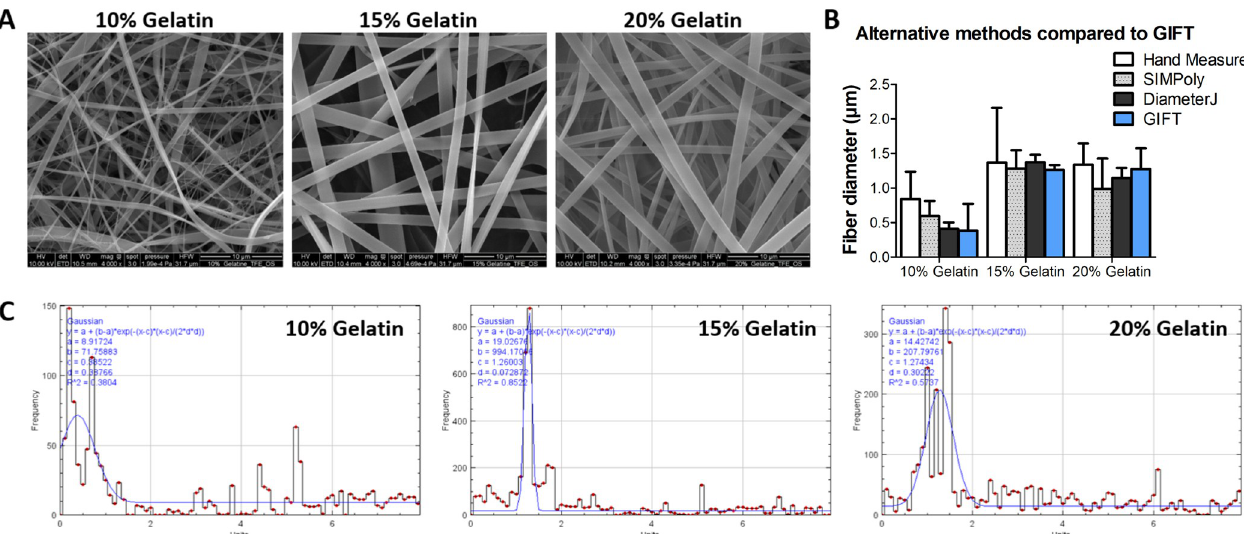
Fig 2. Real world image analysis. A) SEM images of electrospun fibers made from 10, 15 or 20% gelatin solutions. Manual fiber diameter measurements were made on 10 random fibers in each image. B) This SEM image set was also used to test the GIFT macro. The images were analyzed using default GIFT parameters. For comparison, the GIFT results were graphed with the results of hand measurement and DiameterJ and SIMPoly analysis of the same images. C) The fiber diameter histograms produced by the GIFT macro for each SEM image are shown. The x-axis units are μ m. The blue line overlaid on the histograms represents the Gaussian fit curve. The parameters of the Gaussian fit are shown in the upper left corner.